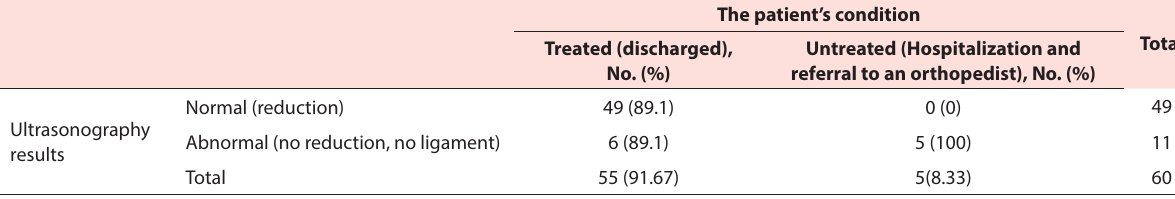
Table 2. Frequency of ultrasonography results based on patient’s treatment (medical) condition a